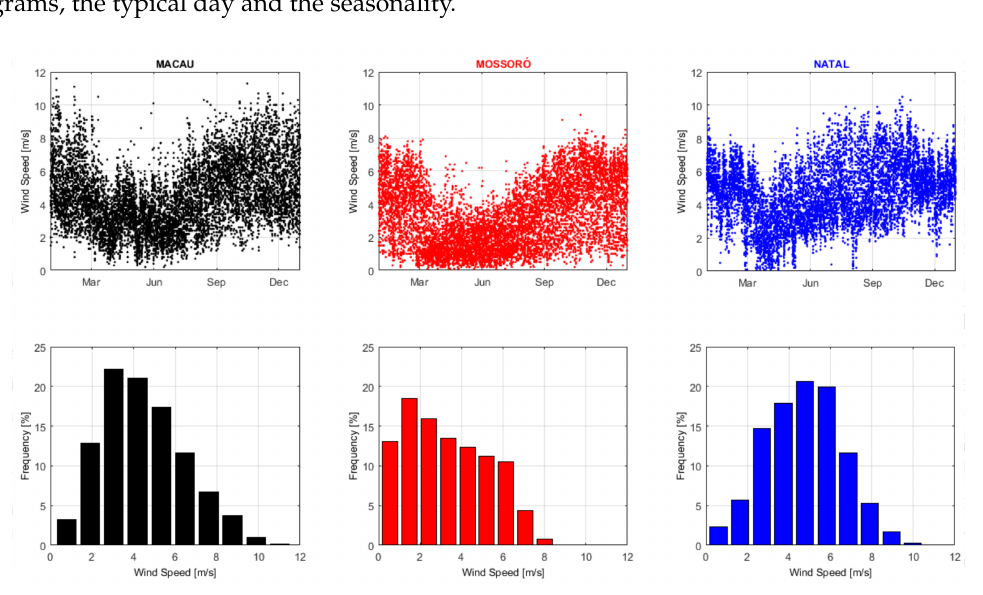
Figure 3. Wind speed time series and histograms. From left to right: Macau, Mossoro and